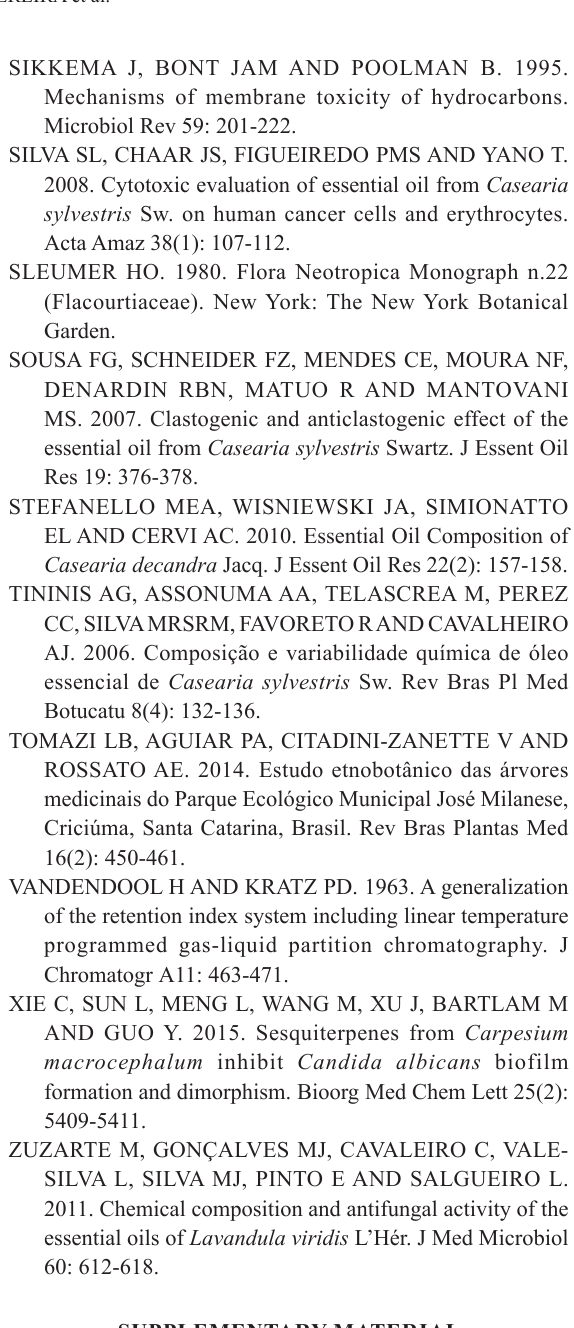
Table SI - Chemical Composition of the Essential Oil from Fresh Leaves of Casearia sylvestris (Jun /2014) and their respectively